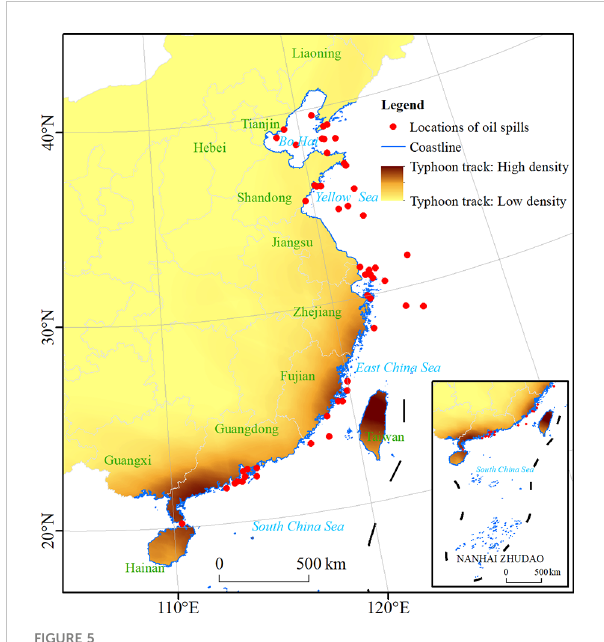
FIGURE 5 Typhoon track density and locations of oil spills since